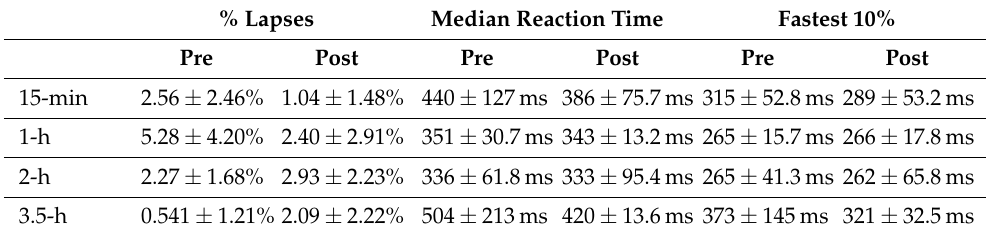
Table 1. Performance metrics derived from an aPVT administered immediately before and at the end of a sequence of light flashes lasting between 15 min and 3.5 h. The percentage of trials that were defined as lapses, median reaction time, and average reaction time of the fastest 10% of the trials are